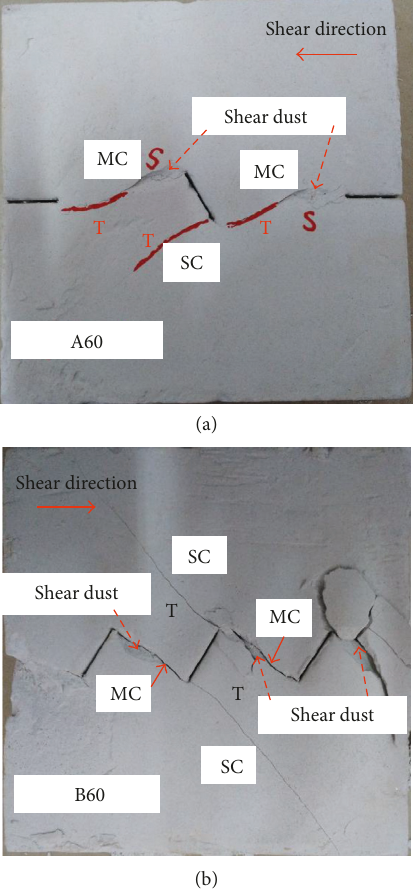
Figure 6: Typical cracks observed in the physical test (Tstands for tensile crack; S stands for shear crack). (a) A60. (b) B60.